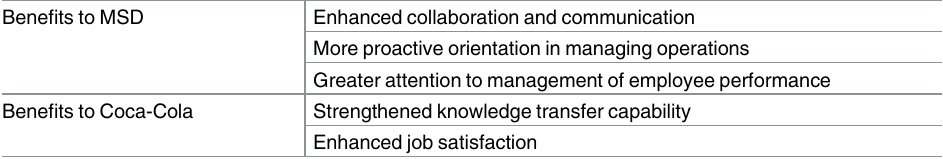
Table 4. Perceived benefits of the